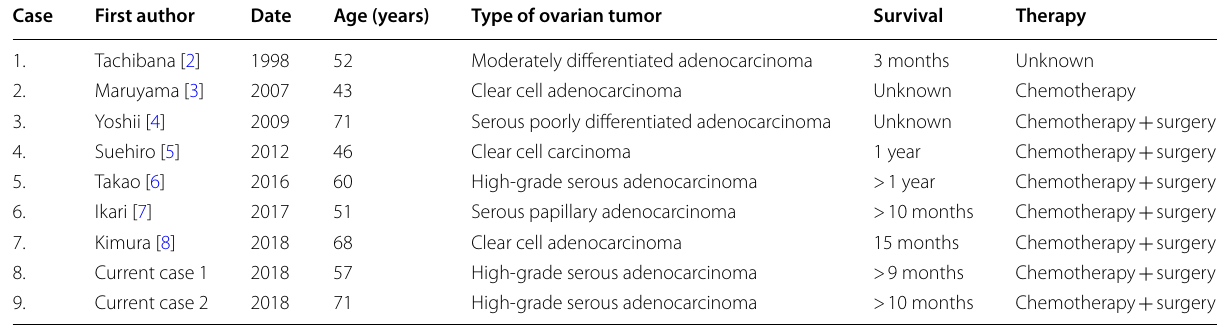
Table 1 Reported cases of metastatic ovarian cancer to the breast (in Japan)